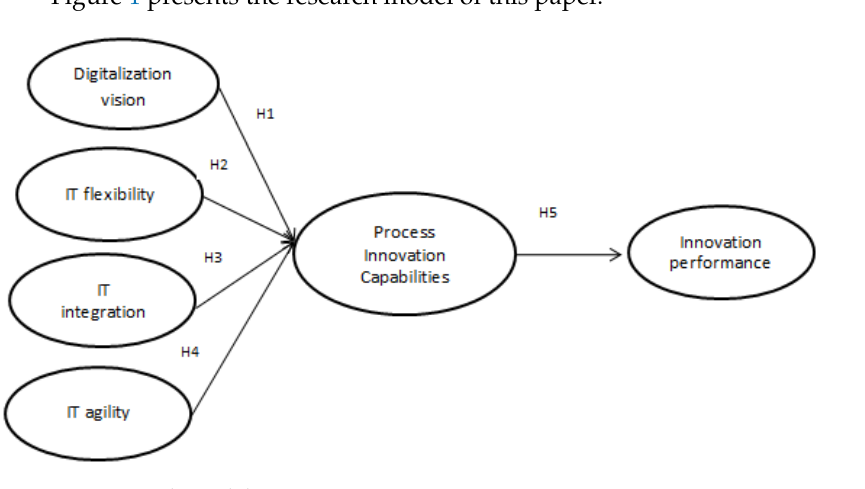
Figure 1. Research Figure 1. Research model.